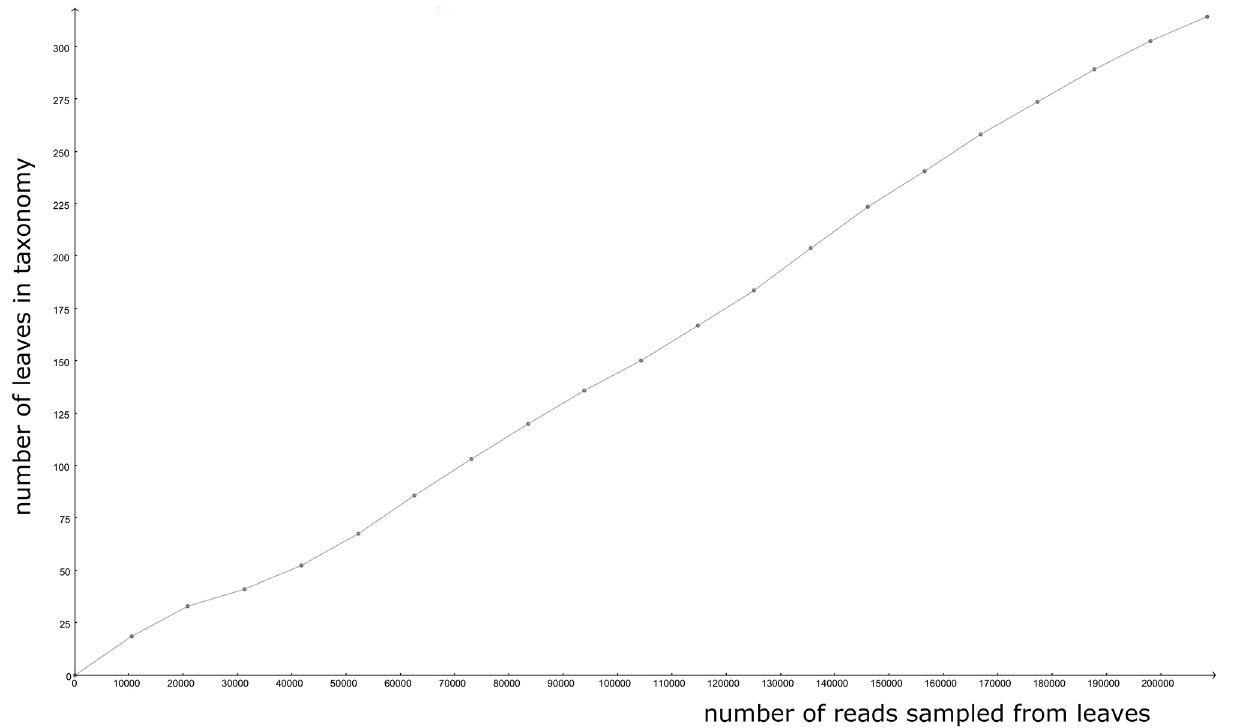
Fig 2. Methane-yielding community composition based on taxonomic assignments from 454-pyrosequencing reads generated using MEGAN5: (A) total reads; (B) reads assigned to the Bacteria domain, (C) reads assigned to the Archaea domain.